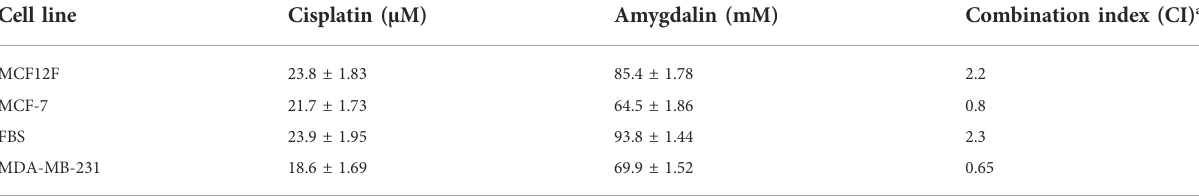
TABLE 1 IC50 values of different cell